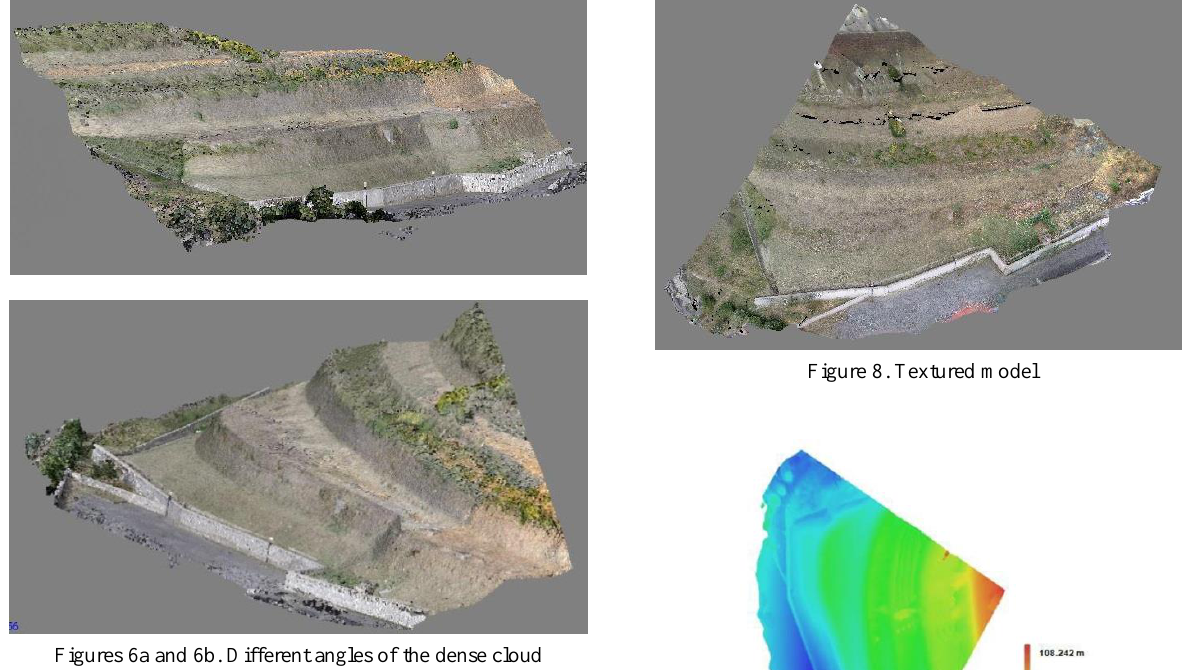
Build mesh , which consists of generating a polygonal pattern based on the dense cloud created. The mesh is